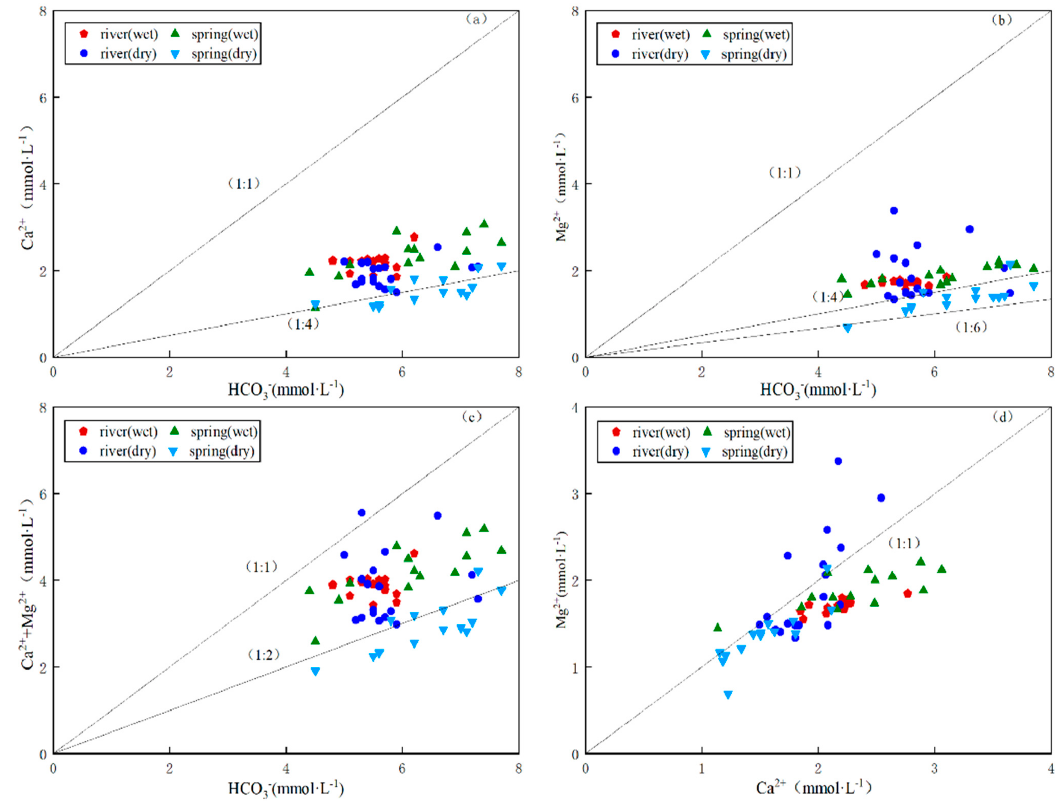
Figure 6. Proportion diagrams of ions with binary hydrogeochemical diagram. ( a ). Ca 2+ /HCO 3 − , ( b ). Mg 2+ /HCO 3 − , ( c ) (Mg 2+ + Ca 2+ ) /HCO 3 − and ( d ) Mg 2+ /Ca 2+ .